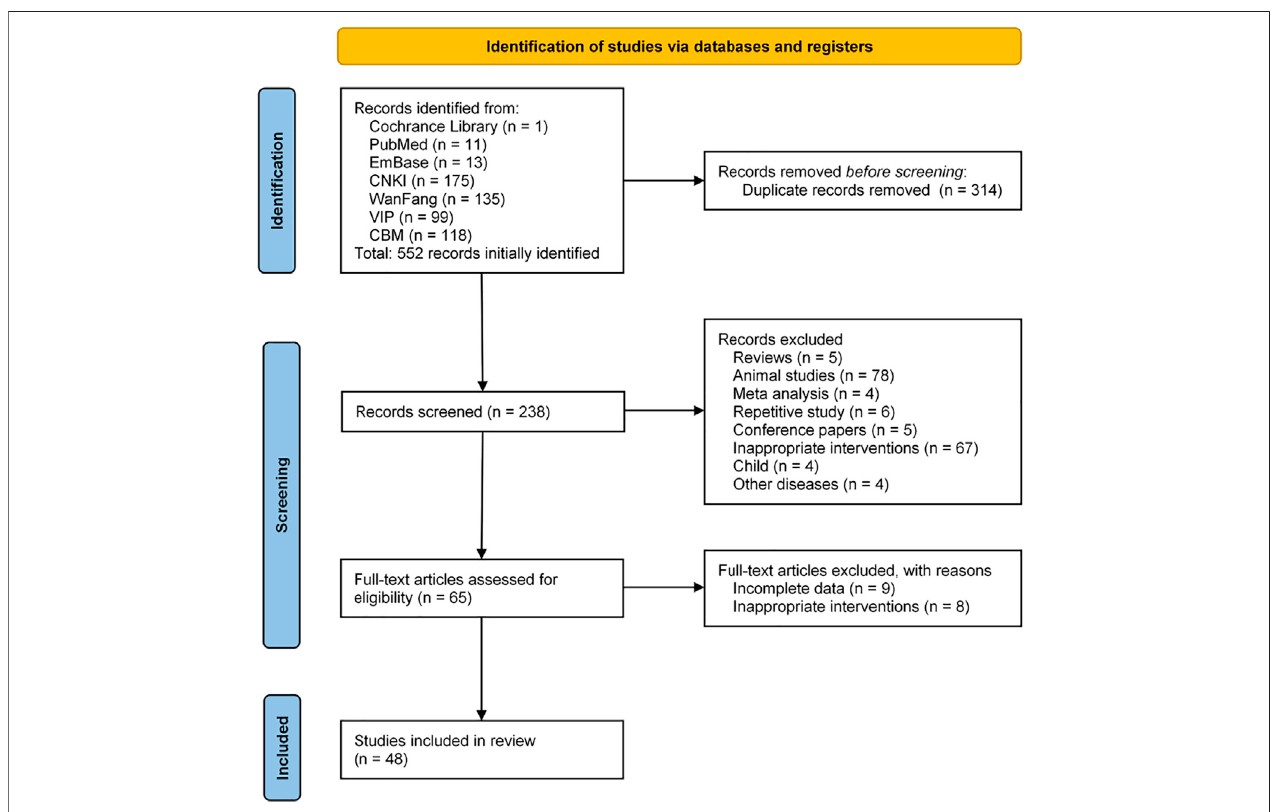
FIGURE 1 | A fl owchart of literature search and selection